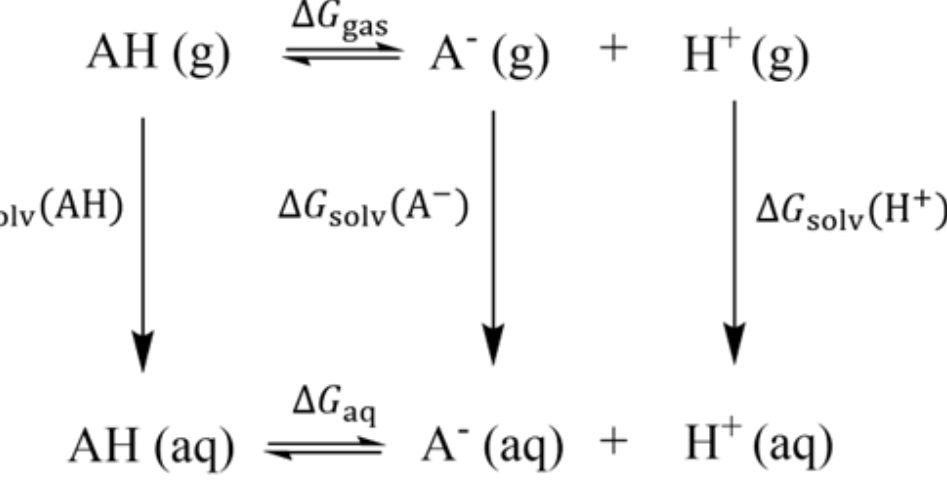
Figure 2. Born – Haber thermodynamic cycle. Figure 2. Born–Haber thermodynamic